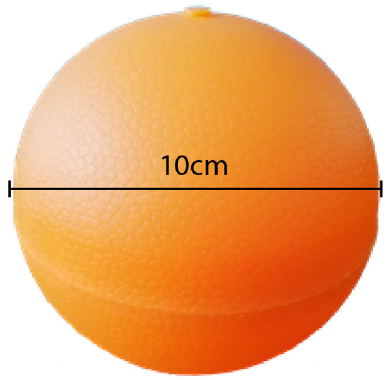
Sensors 2018 , 18 , x FOR PEER REVIEW Figure 5. Mobile node 3D model and physical design. Figure 5. Mobile node 3D model and physical design.